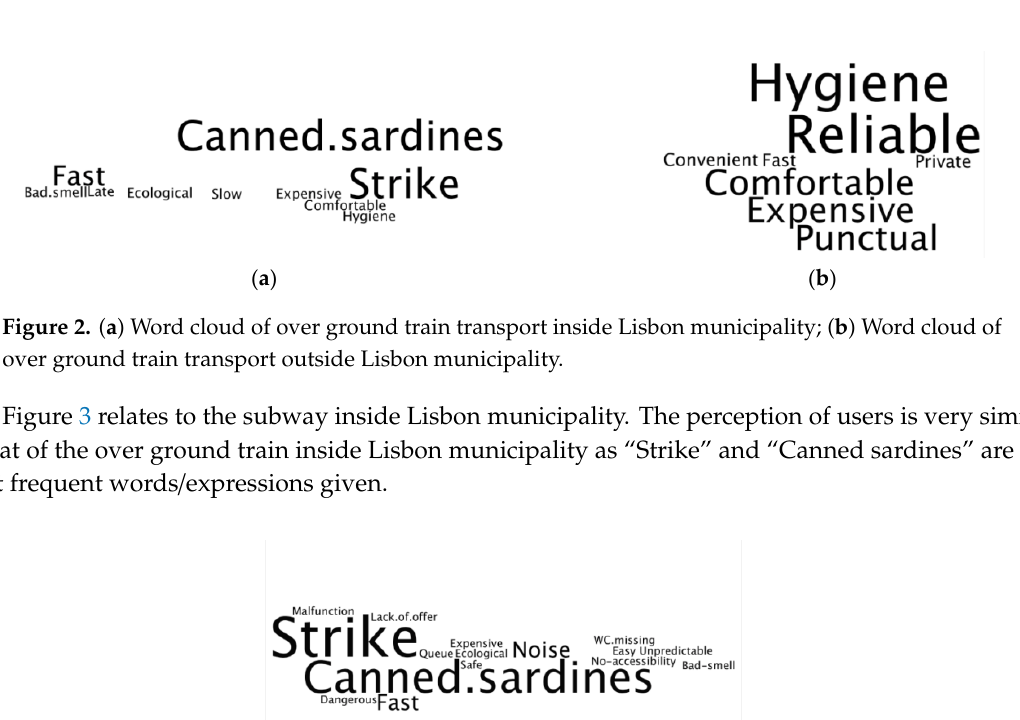
Figure 4. Word cloud of river transport outside Lisbon municipality. 4.3. General Perception of Public Transport Users